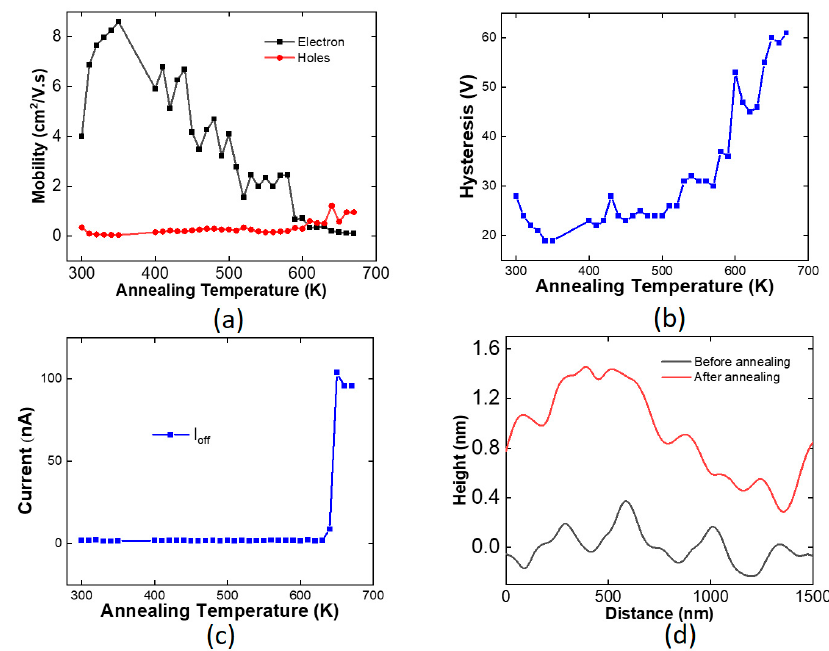
Figure 3. ( a ) The field-effect mobility of the WSe 2 device as a function of annealing temperature. ( b ) The hysteresis of the device as a function of annealing temperature. ( c ) The off current of the device as a function of annealing temperature. ( d ) Surface roughness of WSe 2 as measured by AFM before and after